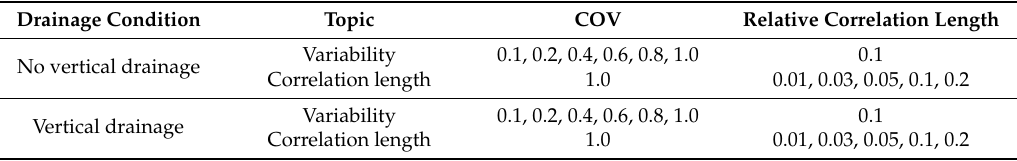
Table 2. Parametric studies. Random variable is hydraulic conductivity, k, following